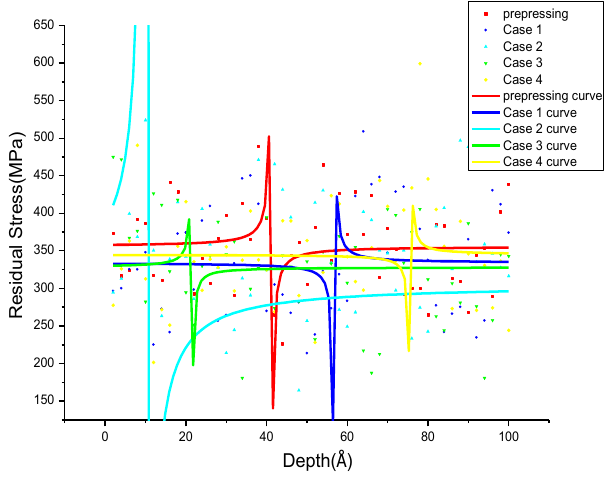
Figure 10. σ zrs distribution after annealing with different annealing parameters.